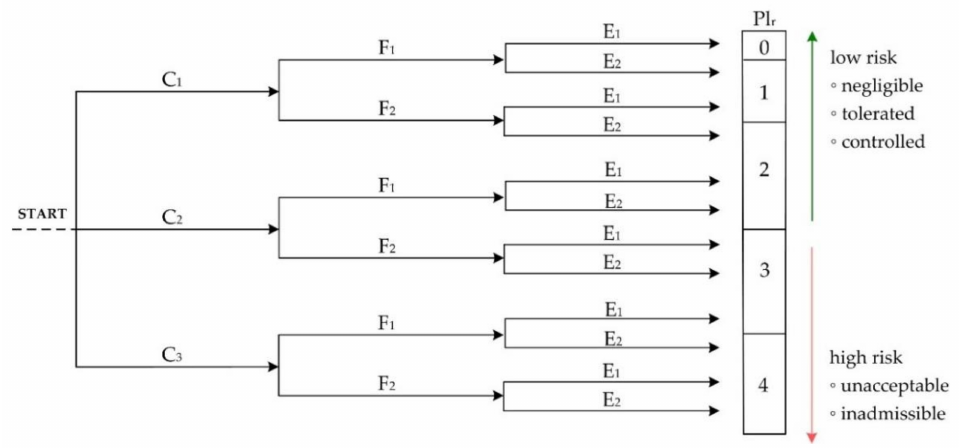
Figure 2. Procedure for determining the required safety assurance (PL r )